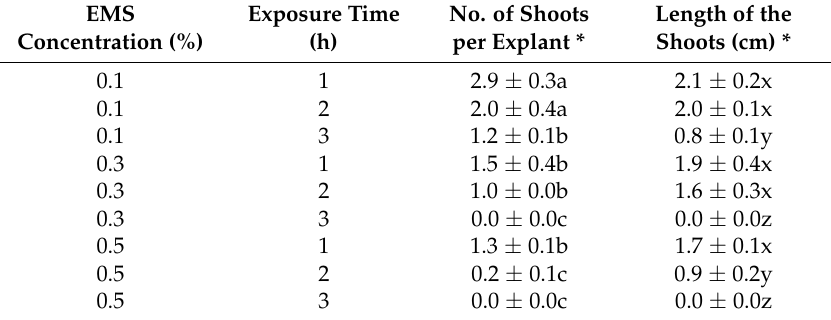
Table 2. Number of shoots per explant after the different treatments with EMS.